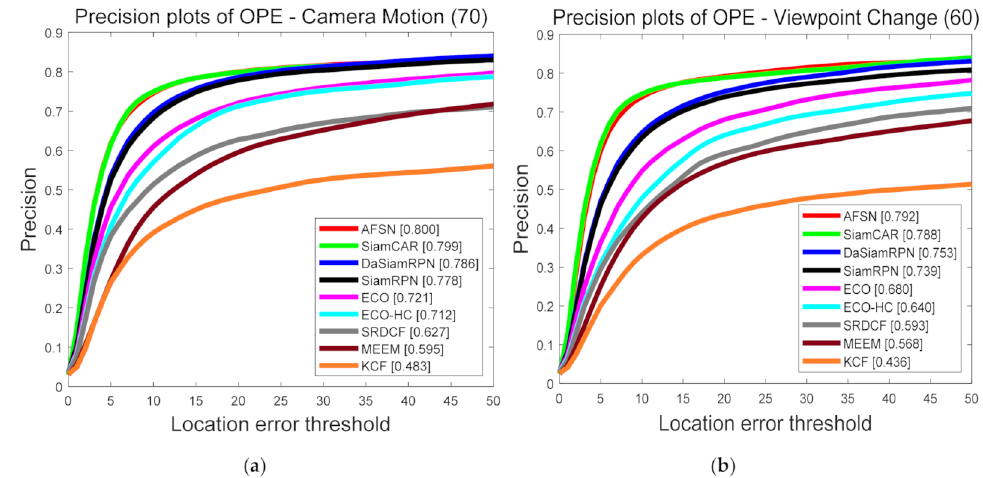
Figure 6. Precision plots for UAV123 in terms of the following attributes: ( a ) camera motion and ( b ) viewpoint change. In both cases, our approach improves the state of the art by a certain margin. AFSN: Anchor-Free Siamese Network; SiamCAR: Siamese Fully Convolutional Classification and Regression; DaSiamRPN: Distractor-aware SiamRPN; SiamRPN: Siamese Region Proposal Network; ECO: Efficient Convolution Operators for Tracking; ECO-HC: ECO with HOG and CN features; SRDCF: Spatially Regularized Correlation Filters; MEEM: Robust Tracking via Multiple Experts Using Entropy Minimization; KCF: Kernelized Correlation